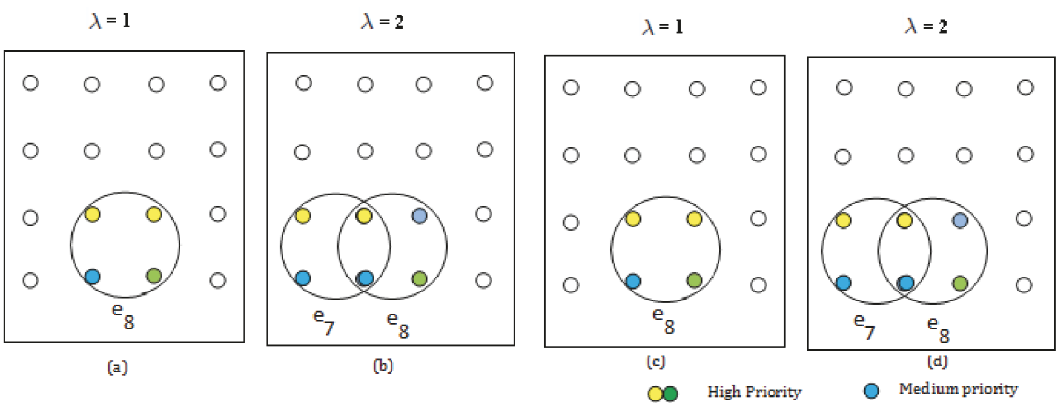
Figure 6: (a)-(b) Opening: 𝛾 𝜆 = [𝛿 𝑒 (𝜀 𝑛 (𝑌 𝑒 ))] 𝜆 . (c)-(d) Closing: 𝜙 𝜆 = [𝜀 𝑒 (𝛿 𝑛 (𝑌 𝑒 ))] 𝜆